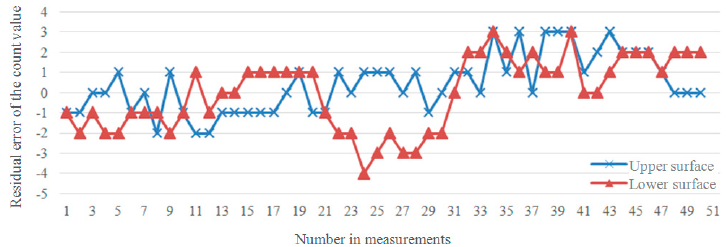
Figure 9. Residual error in count values (speed = 0.67 rad/s). Table 5. Variance distributions at di ff erent